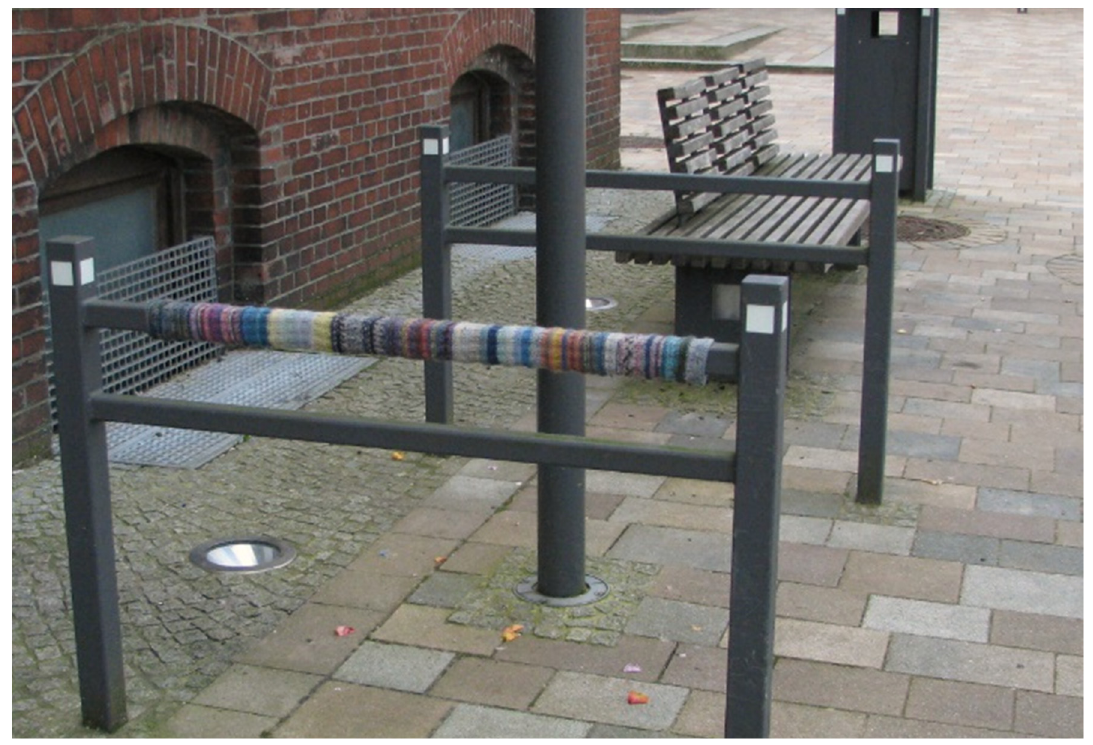
Figure 8. Bike rack in Meldorf, Germany (Photo by Alicja K. Zawadzka, 19 September 2018). Funding: This research received no external funding. Data Availability Statement: Not